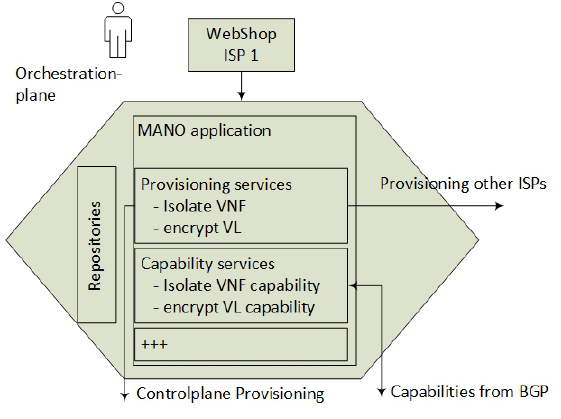
Figure 9. Services in the orchestration